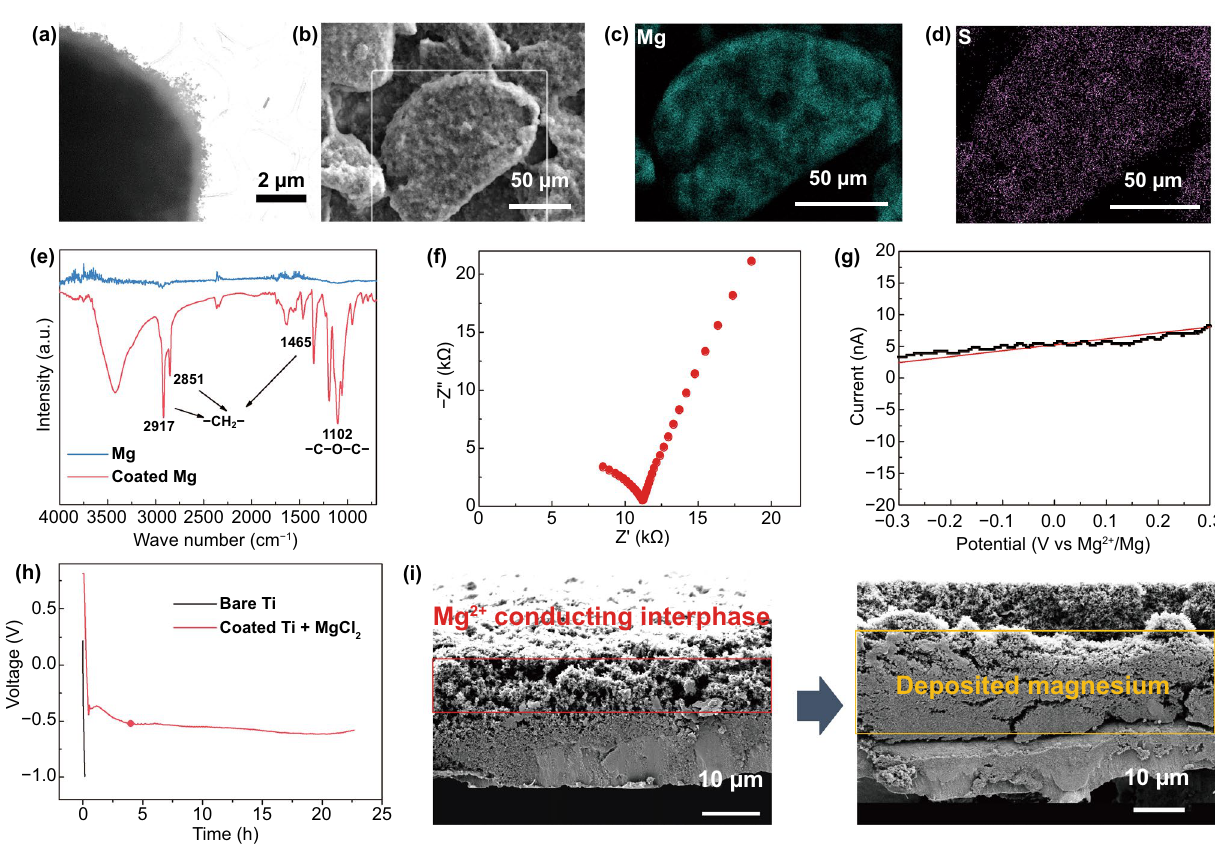
Fig. 2 a TEM imaging of the Mg 2+ -conductive interphase. b SEM imaging of the coated Mg particle and the EDS mapping area is indicated by the white rectangular box. c, d EDS elemental mapping of Mg and S. e IR spectrum of Mg electrode with and without the Mg 2+ -conductive interphase. f Impedance spectra and g linear sweep voltammogram of the Mg 2+ -conductive interphase. The Mg 2+ -conductive interphase is sand- wiched between two stainless steel disks, which act as ion-blocking electrodes. h Voltage profiles of Mg deposition on Ti current collector with and without the Mg 2+ -conductive interphase in 0.5 M Mg(TFSI) 2 electrolyte at a current density of 0.01 mA cm −2 . i Cross-sectional SEM image on pristine-coated Ti electrode and the same electrode after 22 h of Mg deposition. The area of Mg 2+ -conductive interphase is indicated by the red rectangular box, while the area of deposited Mg is indicated by the yellow rectangular